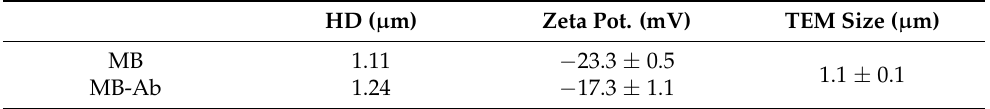
Table 2. Hydrodynamic diameter (HD), polydispersity (PD), zeta potential and TEM size distribution for bare (MB) and conjugated